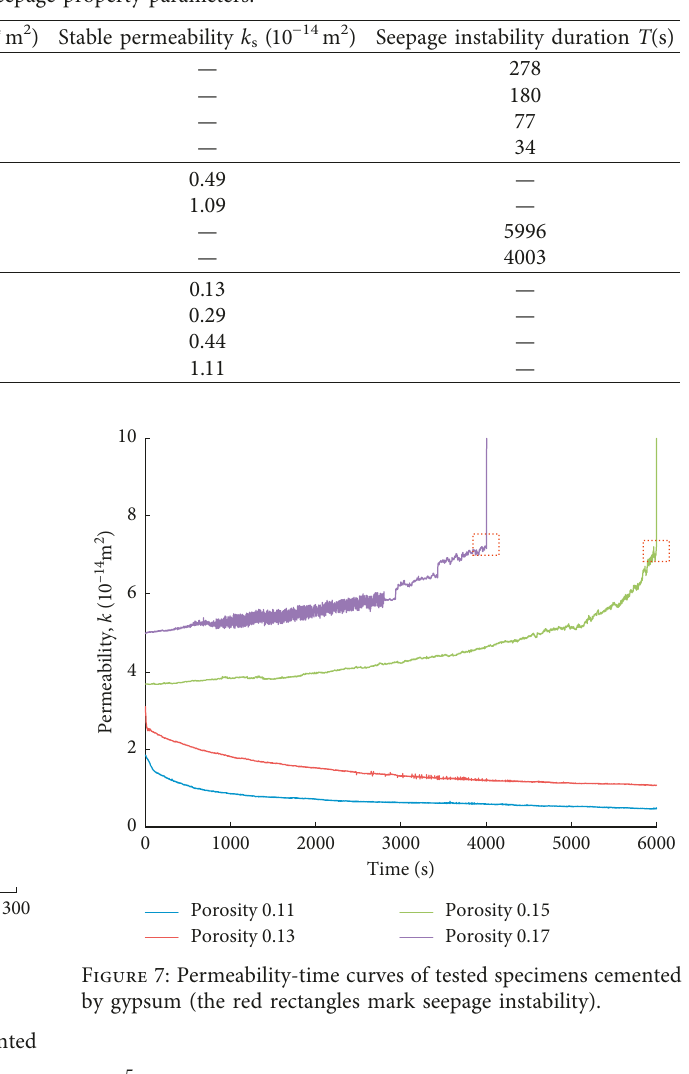
Table 2: The seepage property parameters.